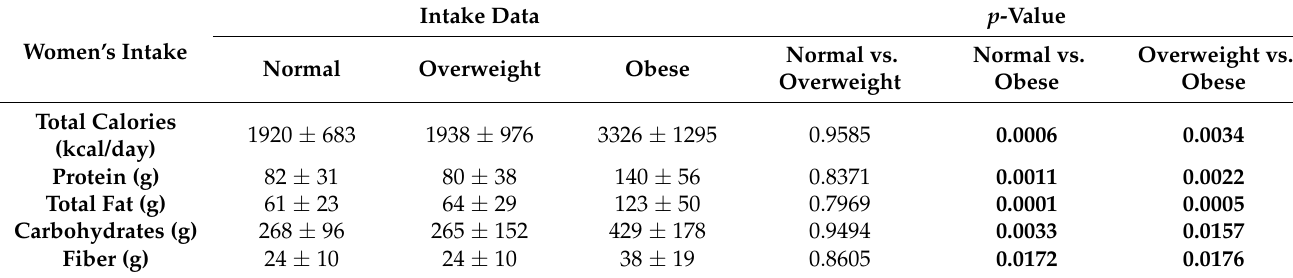
Table 3. Women’s macronutrient